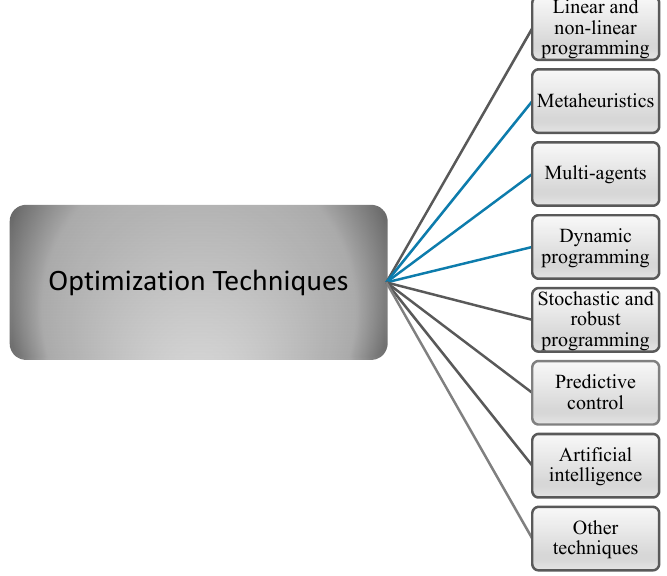
Figure 4. Optimization techniques in microgrid energy management. Table 2. Comparative analysis of optimization mathematical models.